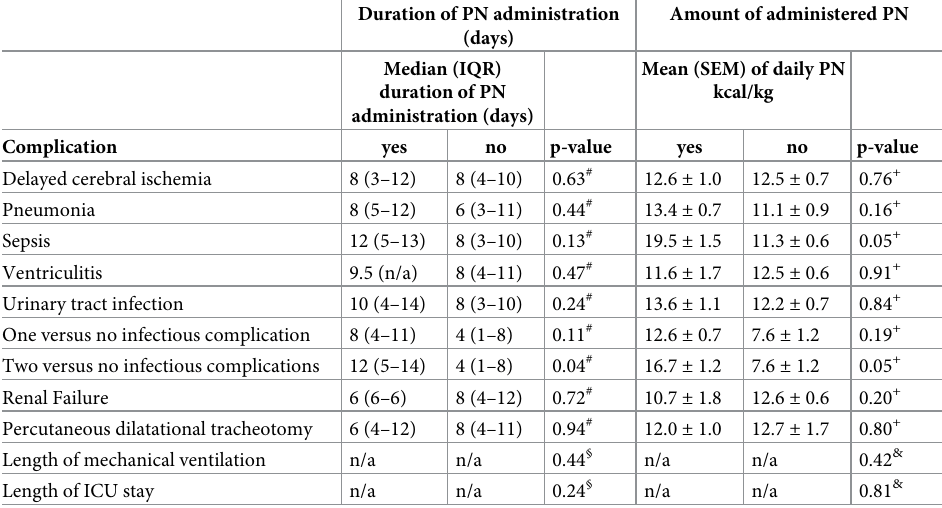
Table 3. Associations between supplemental parenteral nutrition and hospital complications.